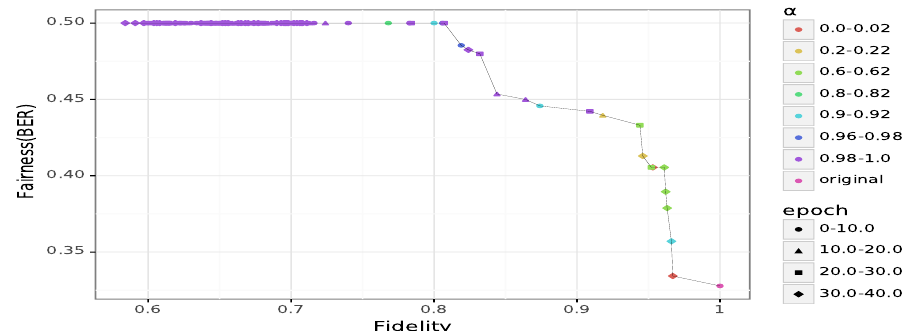
Figure 6. Fidelity-fairness trade-off on German